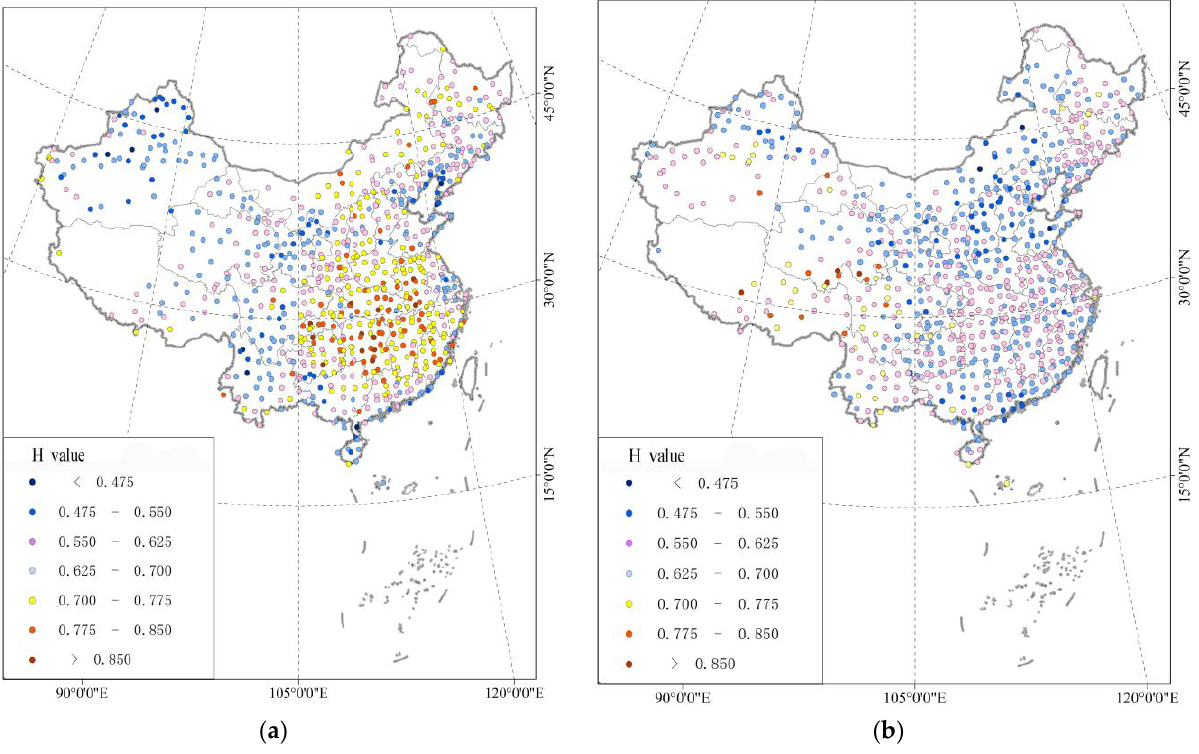
Figure 10. Spatial distribution of H values for TXx and TNn, 1966 – 2015. ( a ) TXx. ( b ) TNn.